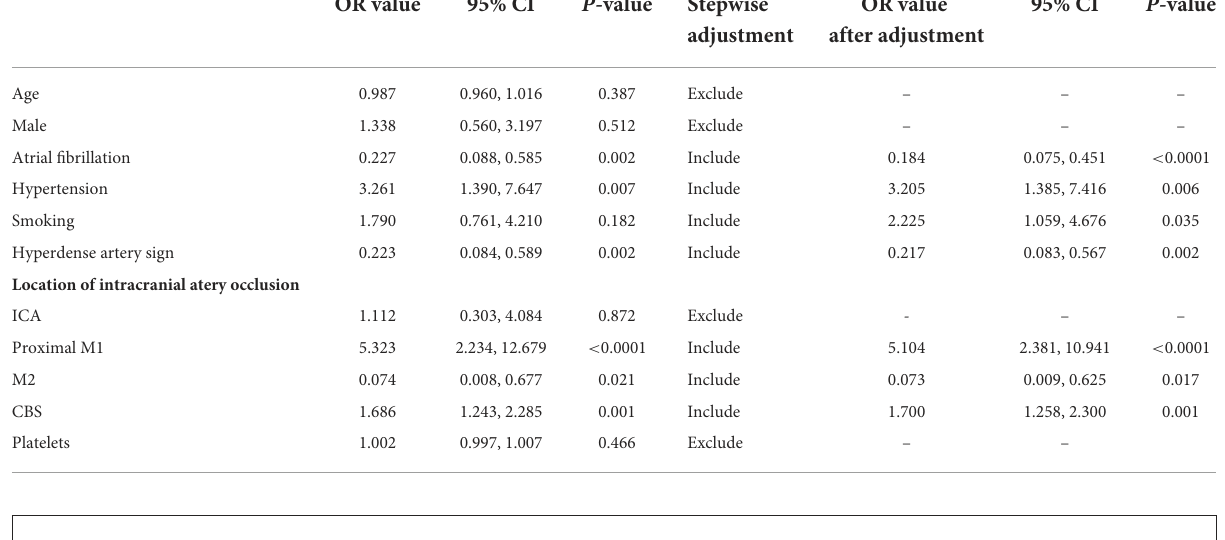
TABLE 3 Results of multivariate logistic regression.